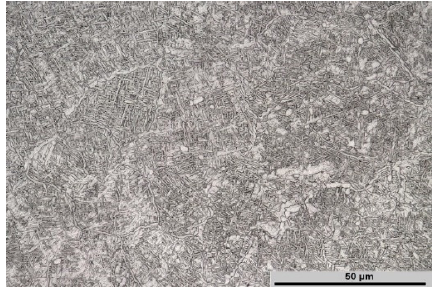
Figure 1. Starting microstructure of Ti-1023 alloy.